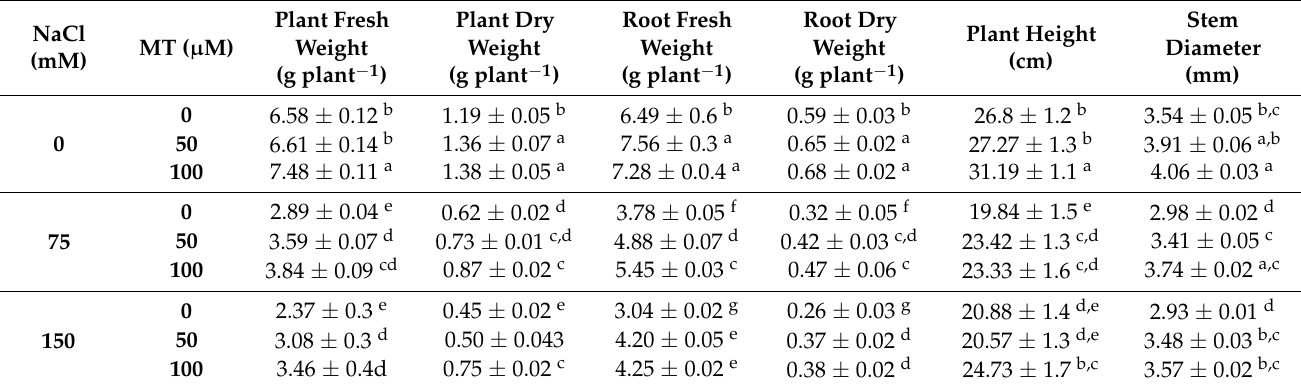
Table 1. Plant growth response of chickpea seedlings under salinity stress to MT